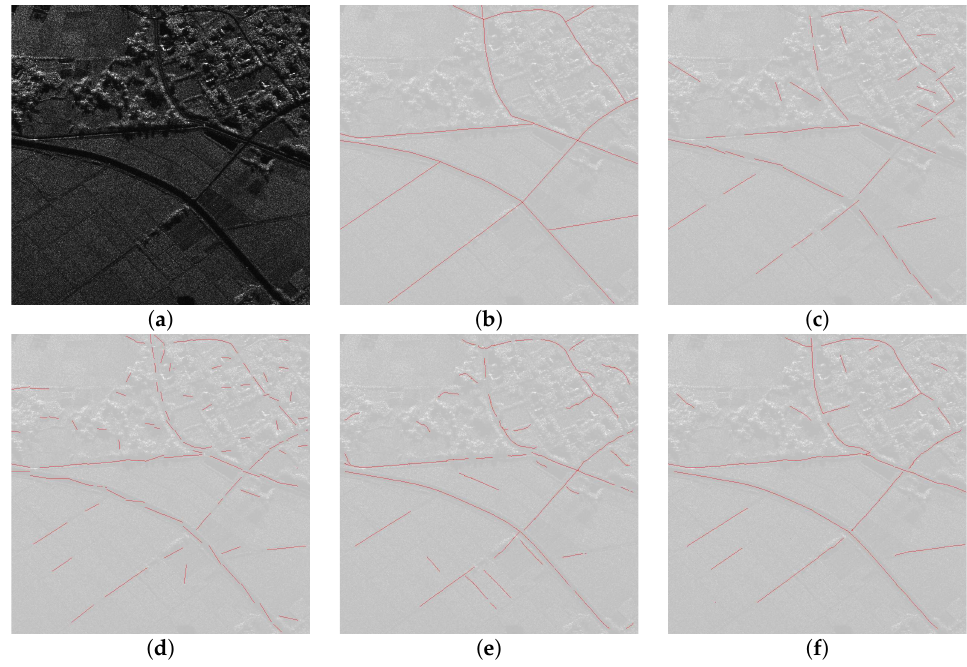
Figure 7. The experimental results on the first airborne SAR image from Hainan, China. ( a ) The span image; ( b ) ground truth; ( c ) results of MLFD; ( d ) results of beamlet; ( e ) results of MRF [8]; ( f ) fusion results of CRF.